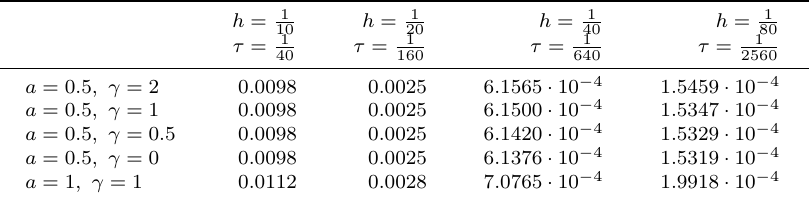
Table 1. The values of absolute error E n